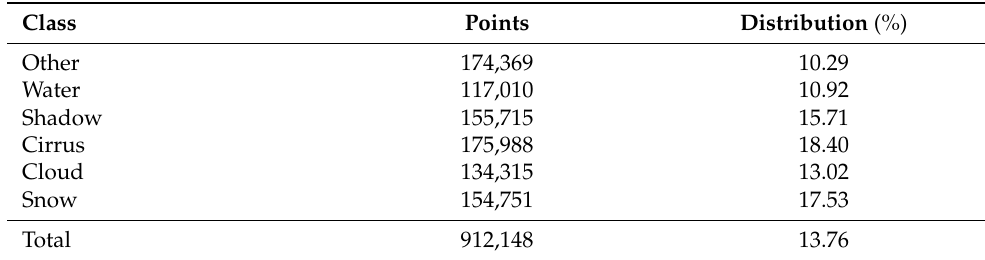
Table 6. Test set: Class-wise Point Distribution (%).